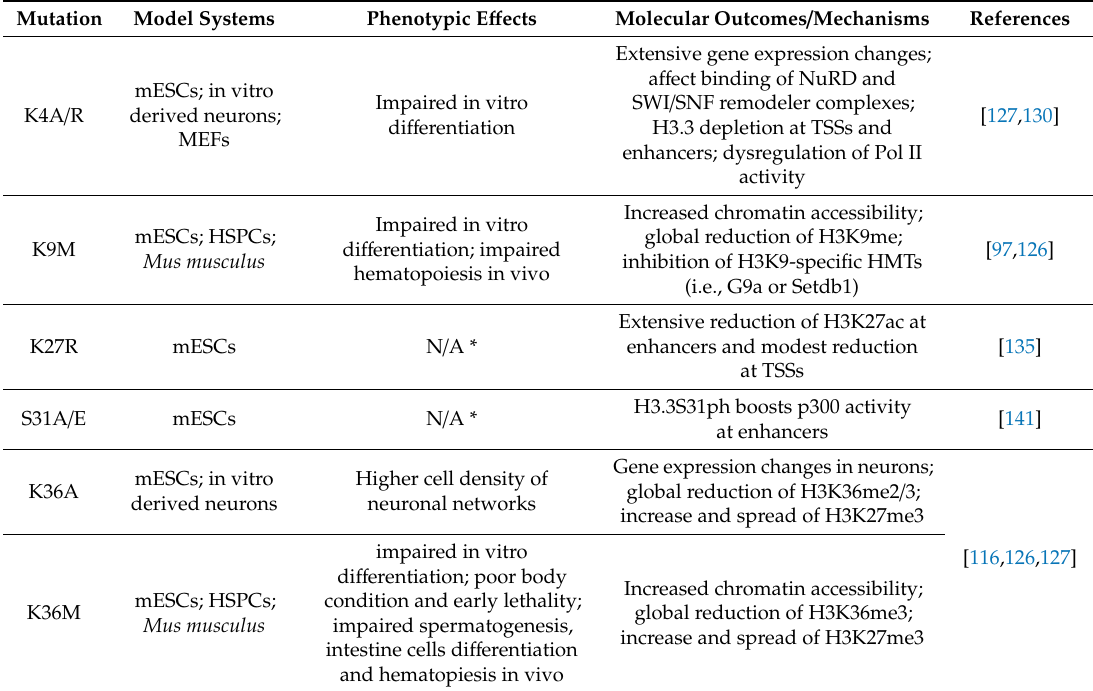
Table 2. Histone H3.3 mutants in mammalian